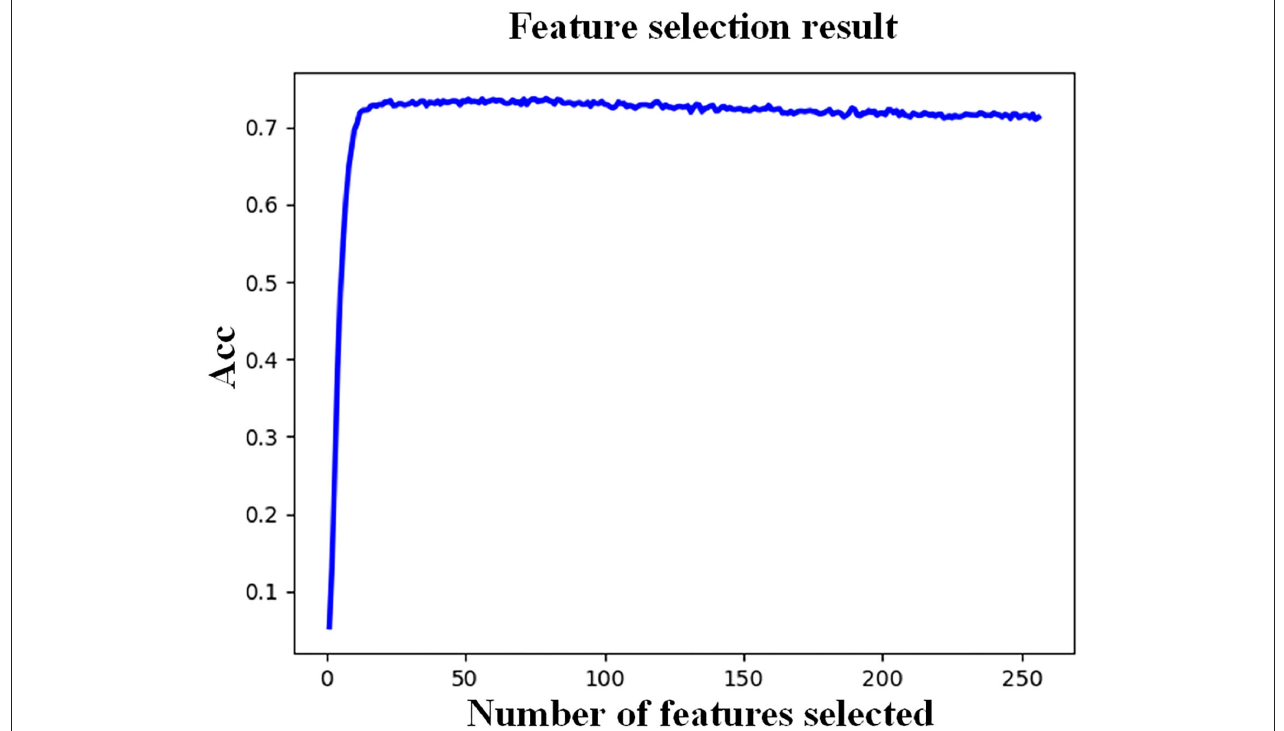
FIGURE 6 | Feature selection result of subject 5.